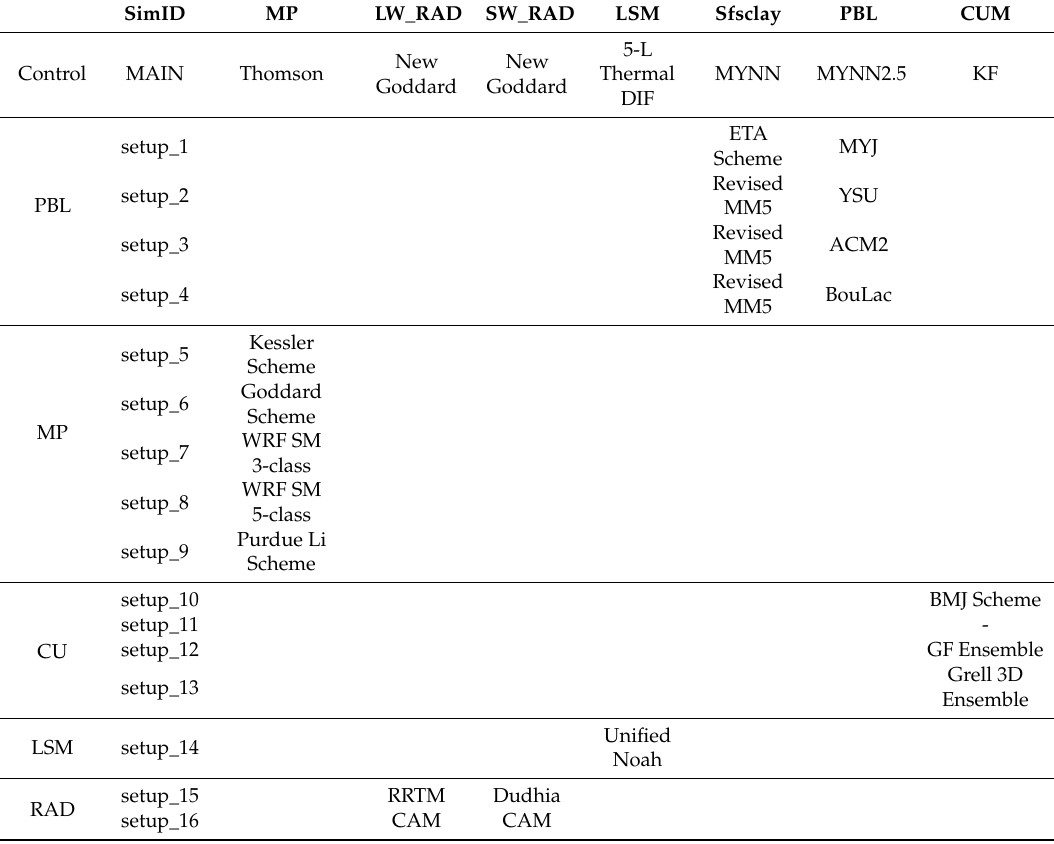
Table 2. WRF model configuration options for: control run, microphysical (MP), longwave Radiation (LW_RAD), shortwave Radiation (SW_RAD), land surface model (LSM), surface layer (Sfsclay), planetary boundary layer (PBL) and cumulus (CUM) experiments. Only the options di ff erent than the control run are